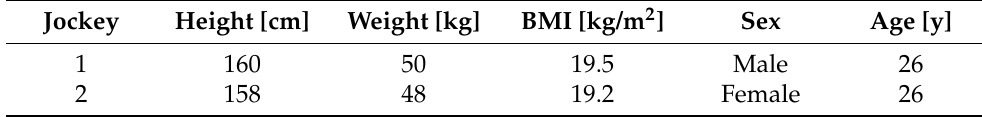
Table 1. Anthropometric characteristics declared by the volunteers. Jockey Height [cm] Weight [kg] BMI [kg/m 2 ] Sex Age